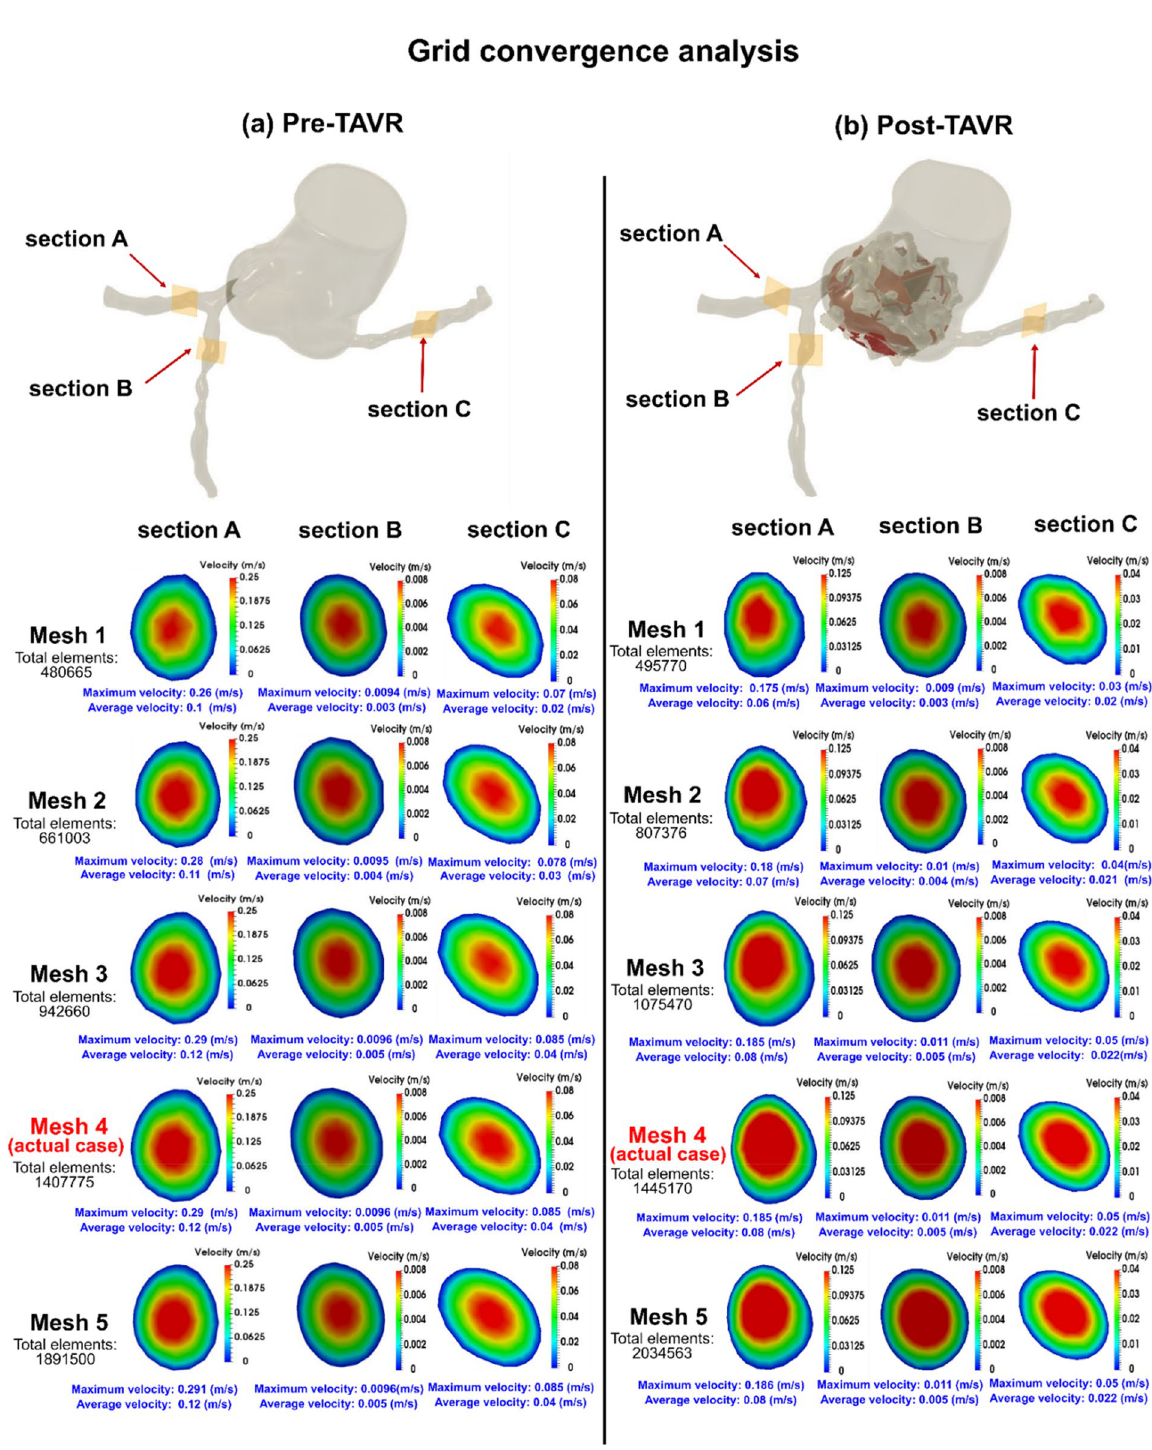
Figure 6. Grid convergence analysis. ( a ) Pre-TAVR: velocity comparisons for different mesh resolutions at the peak of filling phase for different coronary cross sections (sections A,B and C): difference in average velocity between mesh#3 and mesh#4 is less than 0.3% and between mesh#4 and #5 is less than 0.2%—difference in maximum velocity between mesh#3 and mesh#4 is less than 0.5% and between mesh#4 and mesh#5 is less than 0.3%; ( b ) Post-TAVR: velocity comparisons for different mesh resolutions at the peak of filling phase for different coronary cross sections (sections A,B and C): difference in average velocity between mesh#3 and mesh#4 is less than 0.3% and between mesh#4 and #5 is less than 0.2%—difference in maximum velocity between mesh#3 and mesh#4 is less than 0.5% and between mesh#4 and mesh#5 is less than 0.3%; In the aortic root and coronary arteries, the blood flow is laminar and does not experience turbulence during the diastolic phase. In this study, for all 3 patients, we considered the blood flow to be